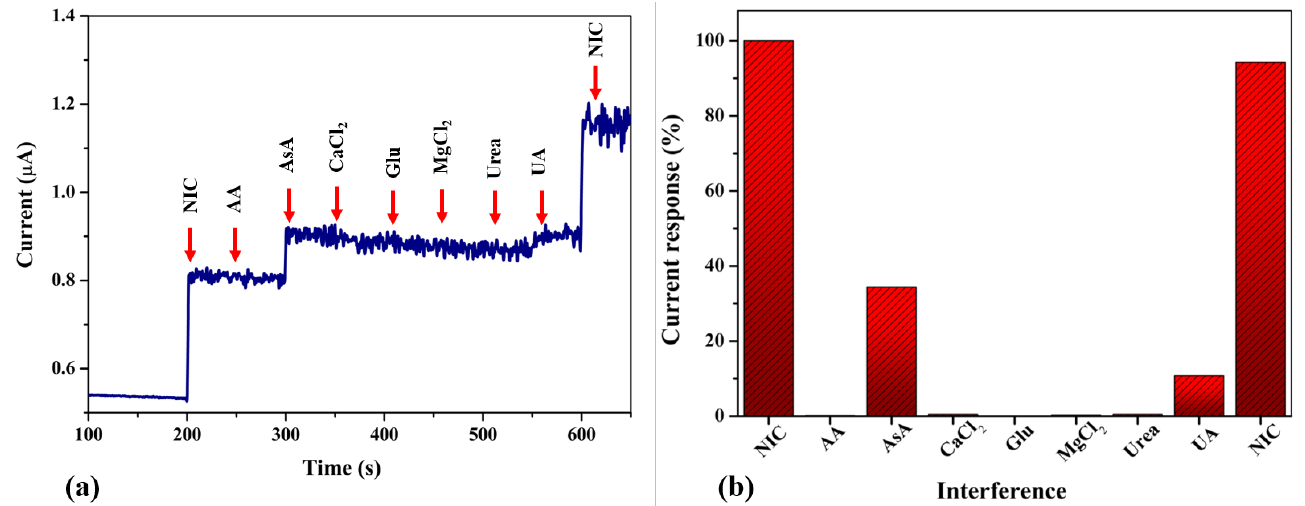
Figure 14. ( a ) Amperogram was recorded for interference compounds with (5 µ M) NIC in 0.1 M PBS using an Ag-NPs/GCE under a rotation speed of 750 rpm, applied voltage of 1 V. ( b ) Bar plot shows the magnitude of current response changes after each addition of interference compounds.